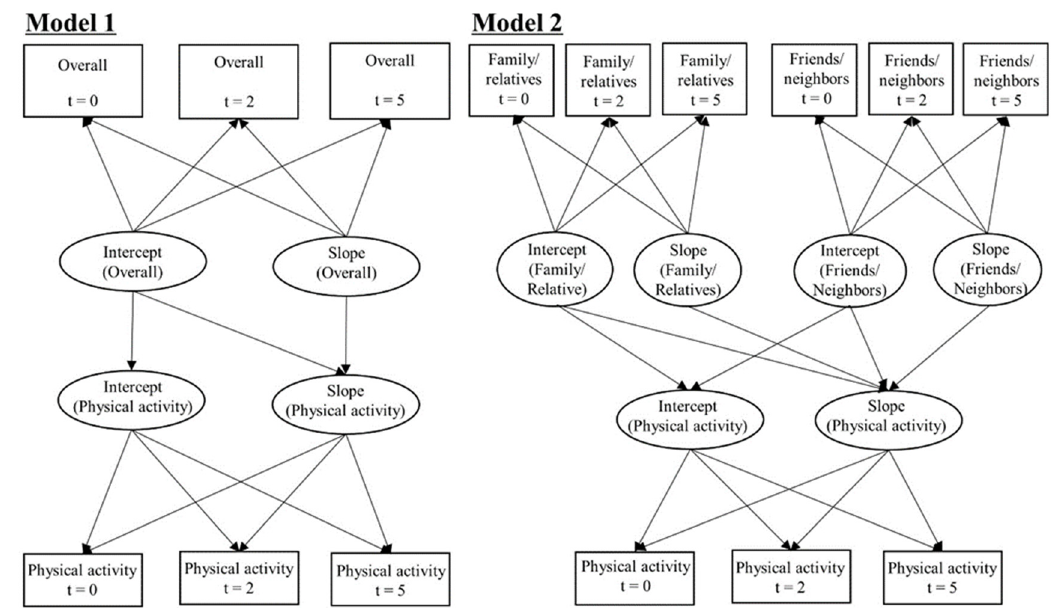
Figure 2. Parallel latent growth curve model fitted to the physical activity with social contact. Model 1 examined the association of frequency of overall social contact with physical activity over five years. Model 2 evaluated the association of each source of social contact with physical activity (family/relatives and friends/neighbors). The models were adjusted for sociodemographic variables (sex, age, years of education, subjective economic status, marital status, employment status), health status (self-rated health, mental health, medical history of diabetes and hypertension), and health behavior (smoking, alcohol, eating habits). Notes: In the figure, t represents the number of years elapsed since the baseline. Overall = frequency of contact with family/relatives/friends/neighbors; Family/Relatives = frequency of contact with family or relatives; Friends/Neighbors = frequency of contact with friends or neighbors.